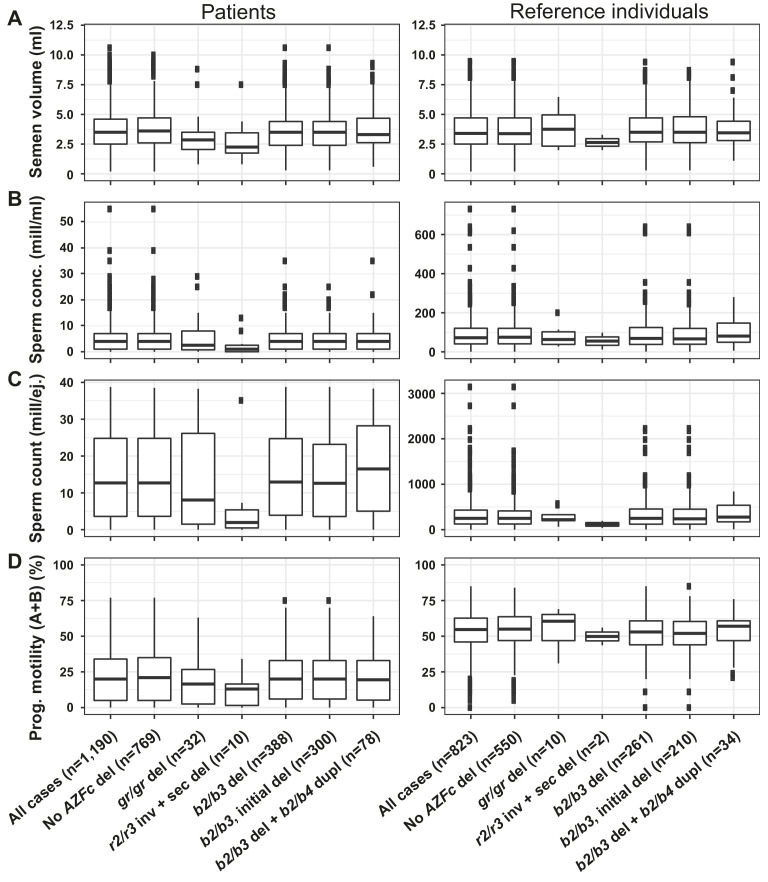
Distribution of seminal parameters in idiopathic male factor infertility cases with spermatogenic impairment and reference subjects.(A) Semen volume, (B) sperm concentration, (C) sperm count and (D) progressive motility. Samples are grouped by genotype with the number of samples (n) shown in brackets. del, deletion; sec, secondary; inv, inversion; dupl, duplication; mill, million; ej., ejaculate. Note different scaling of the Y-axis for the two study groups in (B) and (C).